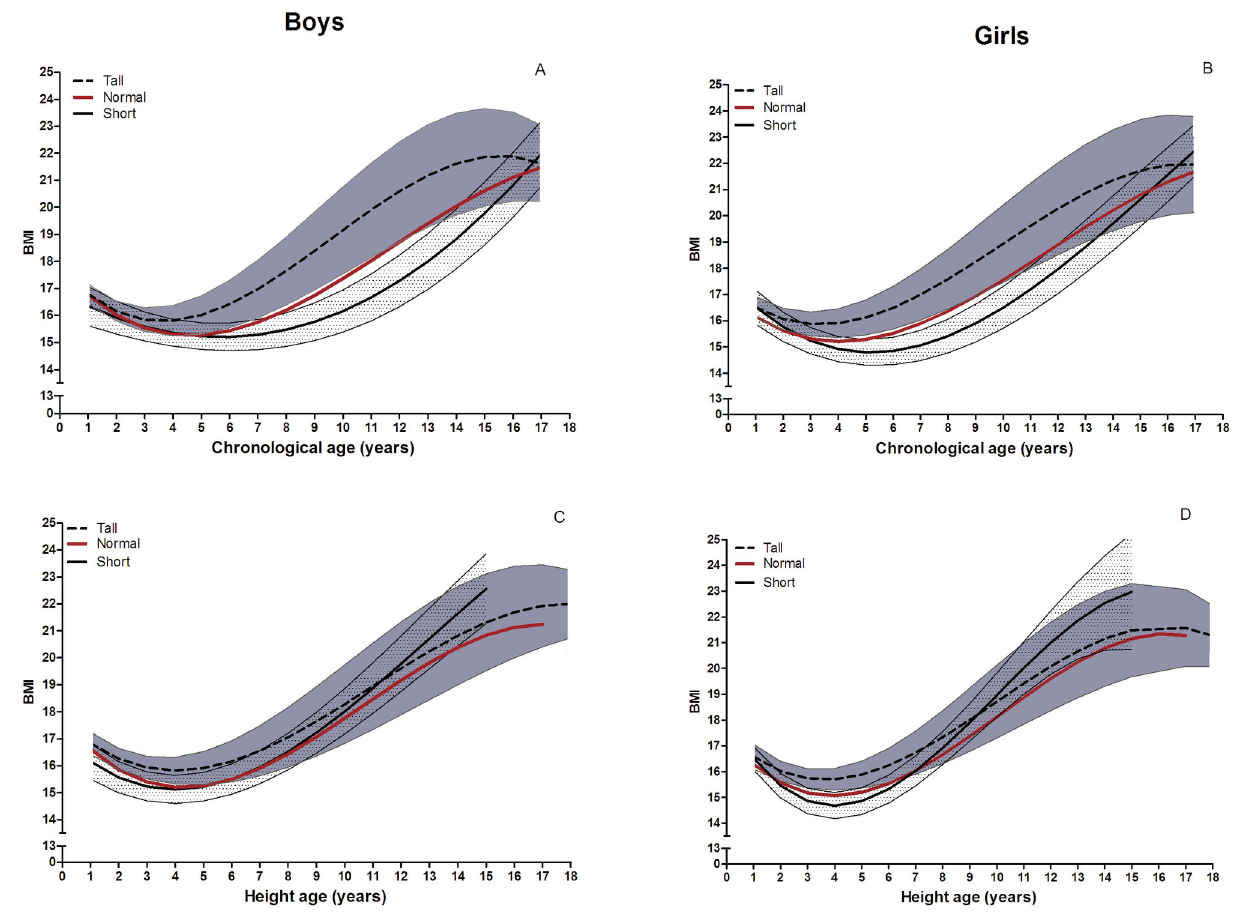
Figure 1. Smoothed median BMI curves for the short (mean height SDS -1.6), normal (mean height SDS 0), and tall (mean height SDS +1.6) sample. BMI according to chronological age for boys (A), girls (B) and BMI according to height-age for boys (C) and girls (D). The dotted lines and the shaded area represent the median BMI and confidence intervals of the tall sample and the short sample,